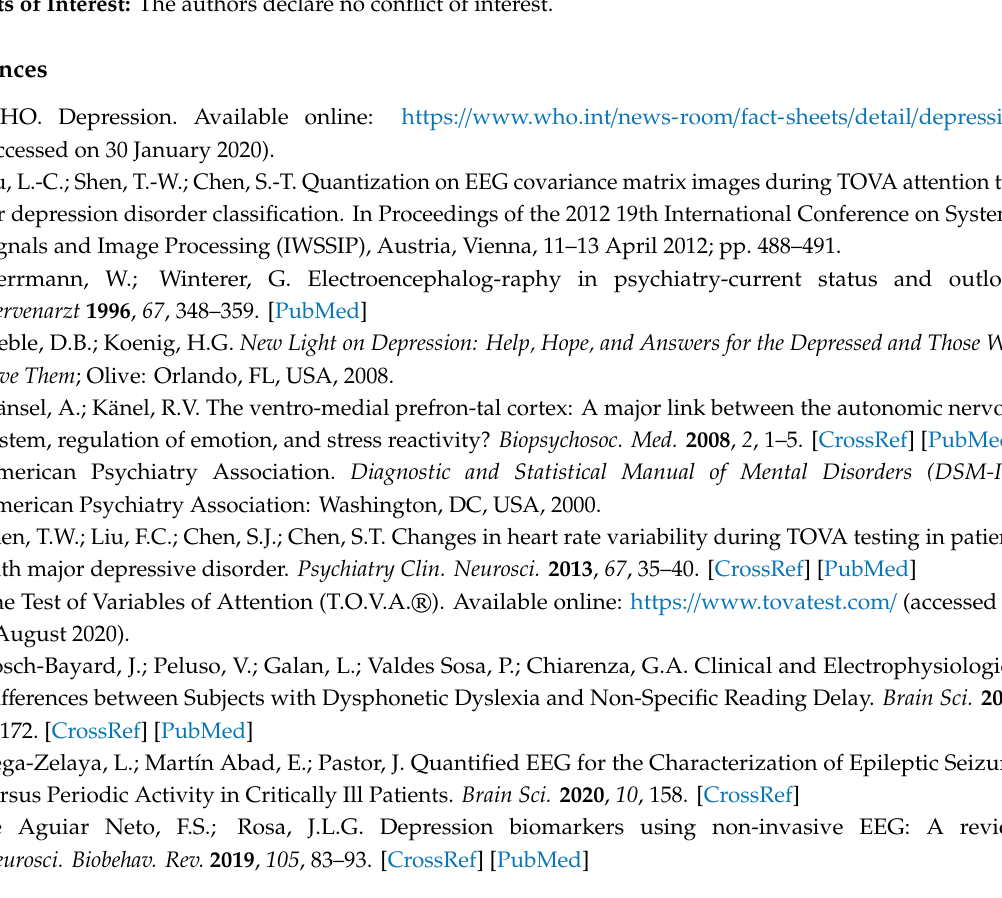
Figure S1: Brain maps of average values of absolute energy in the (a) delta, (b) theta, (c) alpha, and (d) beta frequency bands in the MDD and control groups, Figure S2: Brain maps of the average values of the relative energy in the (a) delta, (b) theta, (c) alpha, and (d) beta frequency bands in the MDD and control groups, Figure S3: Brain maps of the cordance values of the relative energy in the delta (a), theta (b), alpha (c), and beta (d) frequency bands in the MDD and control groups, Table S1: Four band absolute power (unpaired t test), Table S2: Four band relative power (unpaired t test), Table S3: Four band cordance (unpaired t